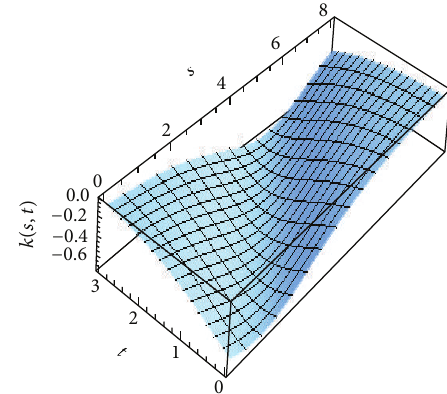
Figure 5: The curvature of the family of curves 𝐶 𝑡 for 𝑠 ∈ [0, 8] , 𝑡 ∈ [0, 3] , 𝑏 = 1.5 , 𝑐